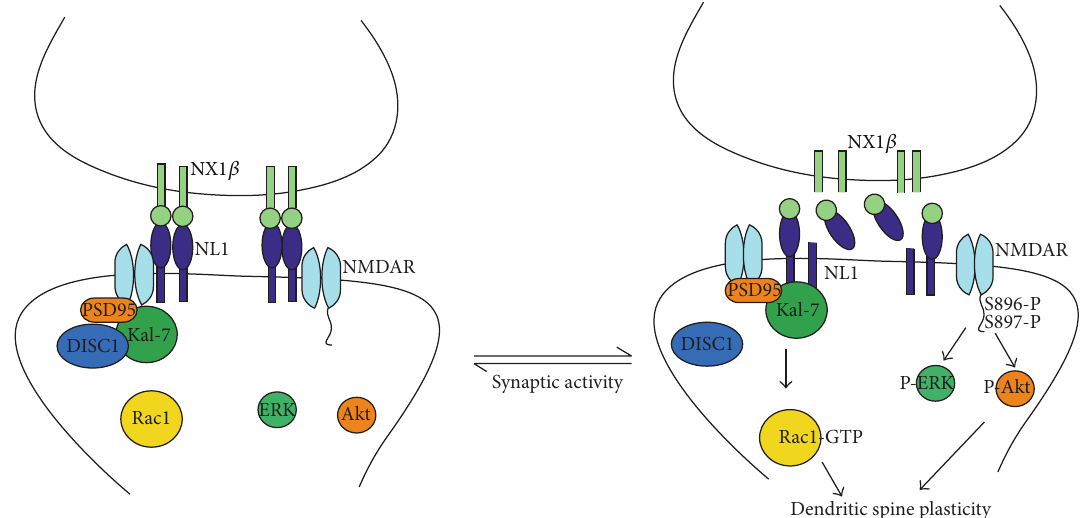
Figure 7: Schematic illustration of possible consequences of the NR1:NL1 interaction with the DISC1/Kal-7/Rac1 signalosome. At the baseline condition, NL1 forms homodimer interacting with NMDA receptor while DISC1 binds Kal-7, blocking the access of Kal-7 to Rac1. Upon synaptic activity and activation of NMDA receptors, NX1 𝛽 is cleaved from the presynaptic membrane leading to partial cleavage of NL1 from the postsynaptic membrane followed by the release of NL1 from NMDA receptor and DISC1 from Kal-7. After the shedding, NL1 is no longer a dimer which probably changes the mobility of N-terminally truncated NL1, and it can diffuse allowing NL1 to bind Kal-7 and in turn lead to the activation of Rac1. These events eventually allow NL1 to bind Kal-7 and in turn lead to the activation of Rac1. Additionally, binding of ecto-NX1 𝛽 to NL1 results in NR1 subunit phosphorylation at S896 and S897 and phosphorylation of ERK and